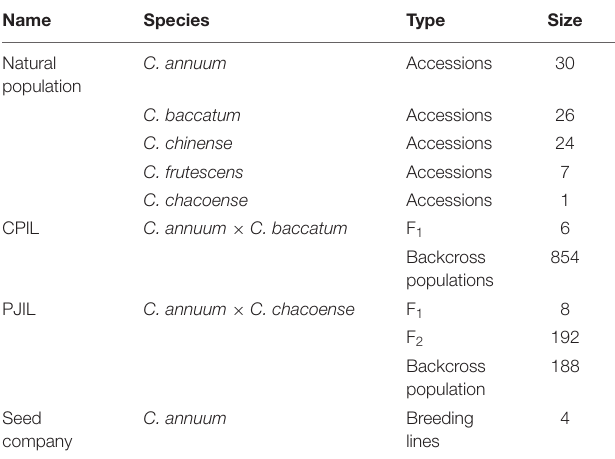
TABLE 1 | Summary of plant populations used for GT-seq library